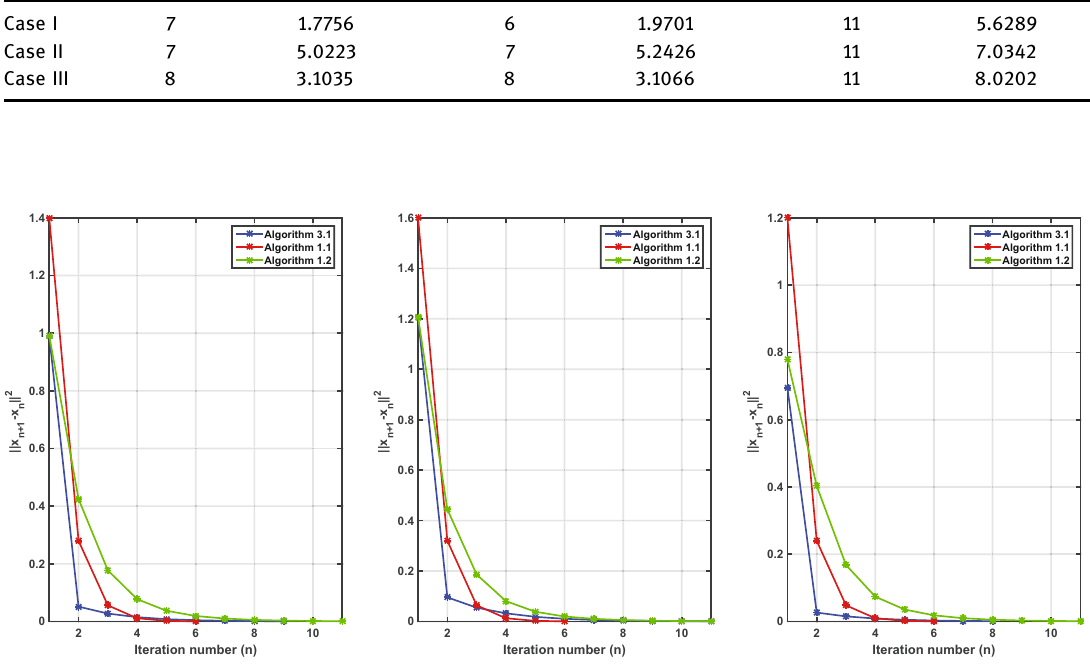
Algorithm 3.1 Algorithm 1.1 Algorithm 1.2